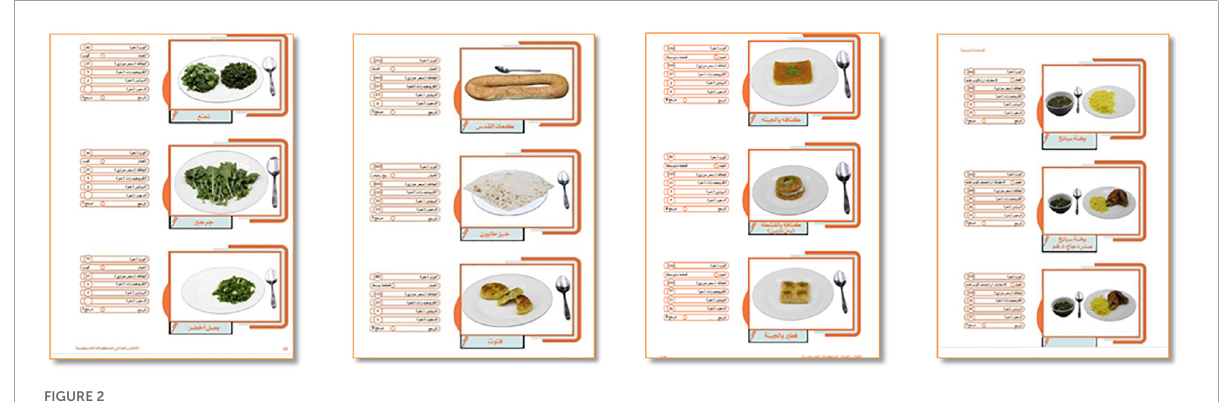
FIGURE2 Sample from the developed photographic food atlas, different